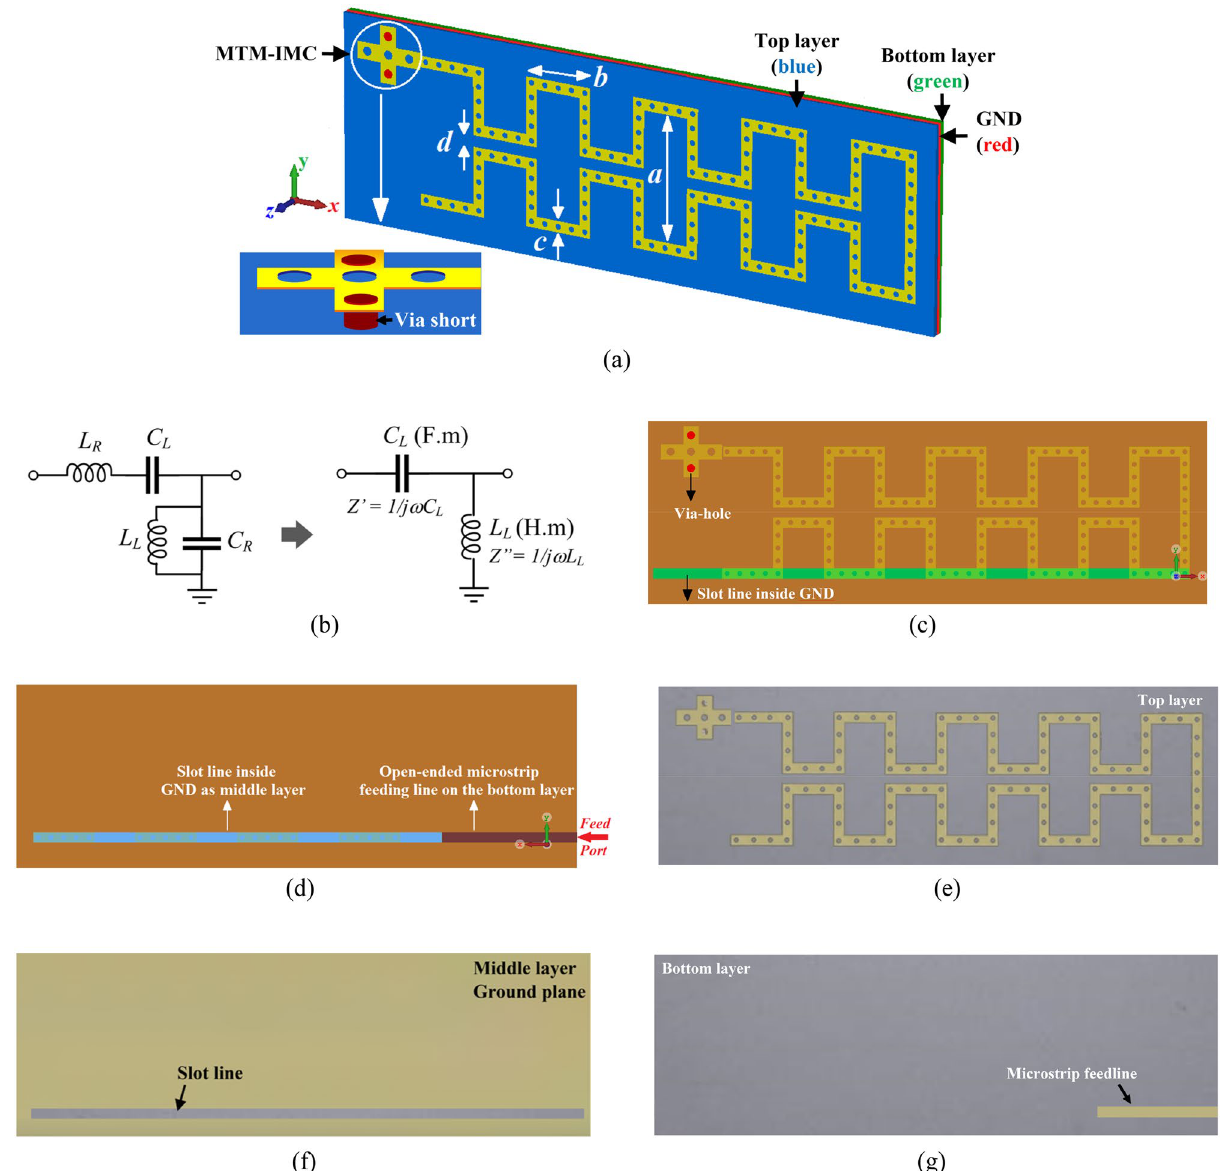
Figure 1. Proposed on-chip antenna, ( a ) simulated isometric view of the OCA structure showing a close-up view of the MTM-IMC, ( b ) equivalent circuit model of the MTM-IMC, ( c ) top-view of the antenna layout along with an overview of the coupling slot line on the ground plane showing its precise location underneath the slotted meandering line, ( d ) back-side of the simulated layout with an overview of the coupling slot line on the ground plane showing its precise position in relation to the open-ended microstrip feedline, ( e ) top-view of the fabricated prototype OCA, ( f ) fabricated middle ground-plane layer (GND) with coupling slot line, and ( g ) fabricated back-side of the OCA showing the open-ended microstrip feedline, which is shielded with a substrate layer whose outward face side is a ( L L ) 17 . The MTM-IMC structure has unavoidable fringing fields resulting from the currents flowing on the surface of the antenna and the gap between the surface and the ground-plane. Hence, the fringing fields create right-handed parasitic elements of series right-handed inductances ( L R ) and shunt right-handed capacitances ( C R ) associated with the left-handed components. The equivalent circuit of the MTM-IMC is shown in Fig. 1b. The magnitude of the reactive components resulting from the fringing fields are negligible and can be therefore ignored in the analysis. The equivalent circuit then simplifies to series C L and shunt L L . For simplicity, assum- ing loss-less case, the propagation constant γ , the propagation constant β , the phase velocity v p , and the group velocity v g of the transmission-line can be shown to be given by